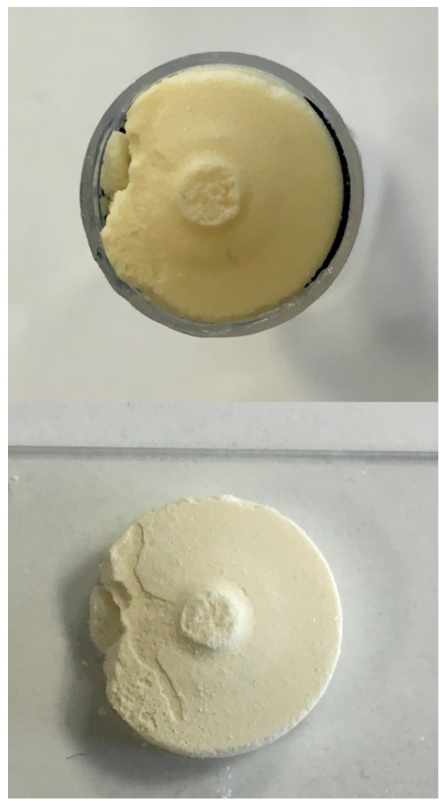
Figure 6. Agglomerate of formulation 1 in the opened syringe cylinder (top) and following drying on a microscopic slide (below).